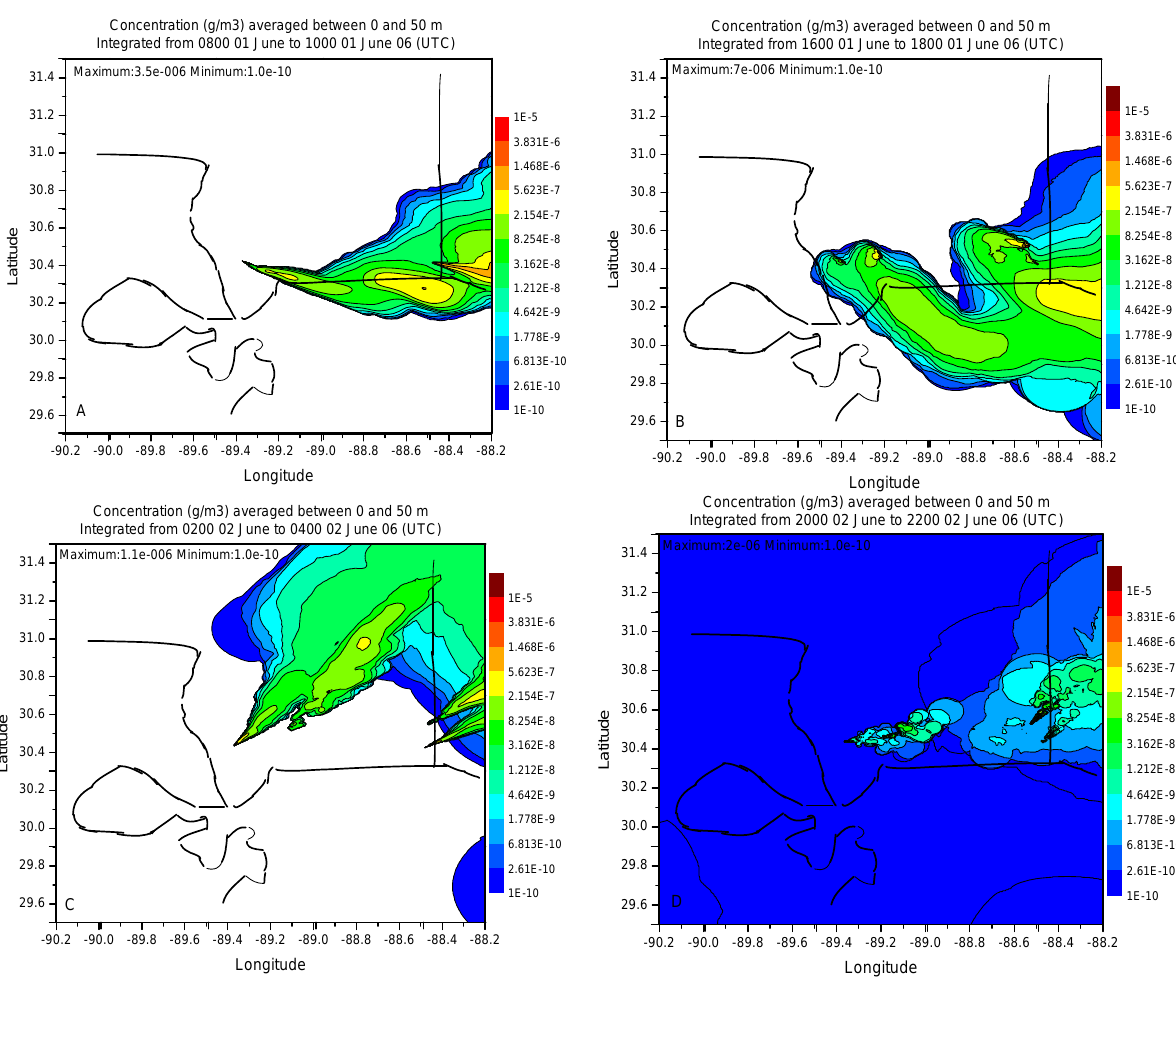
-90.2 -90.0 -89.8 -89.6 -89.4 -89.2 -89.0 -88.8 -88.6